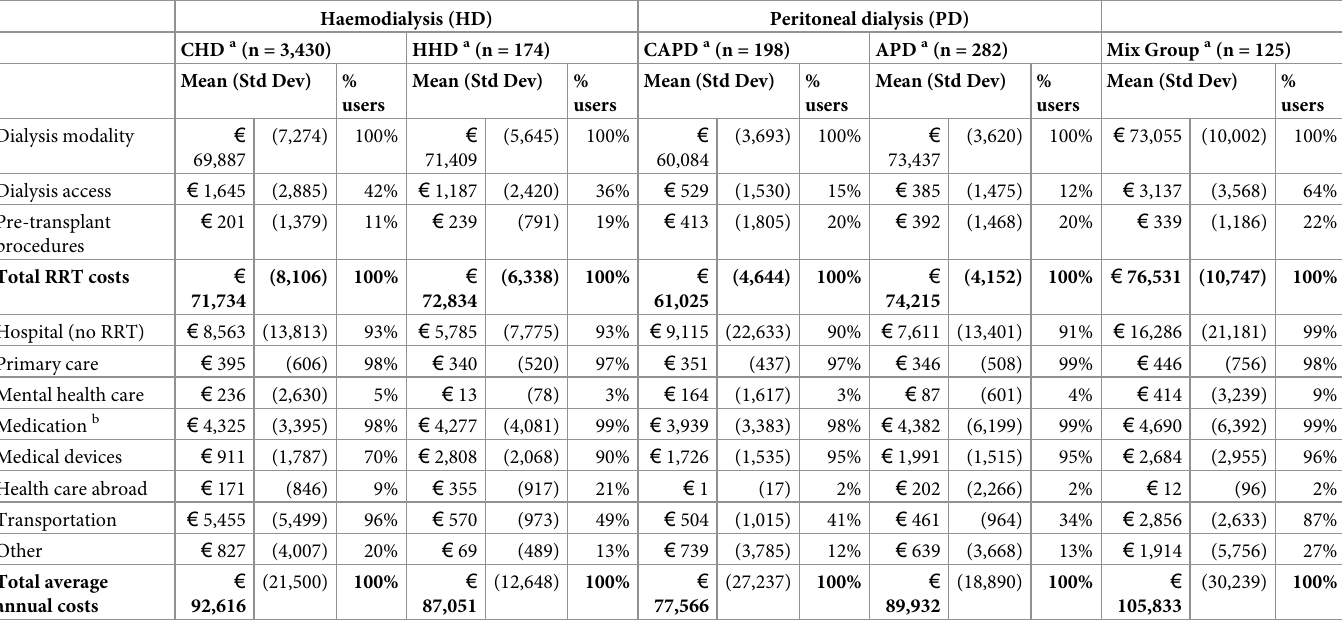
Table 2. Average annual healthcare costs per dialysis modality, for FYD patients (Full Year on Dialysis) ( €